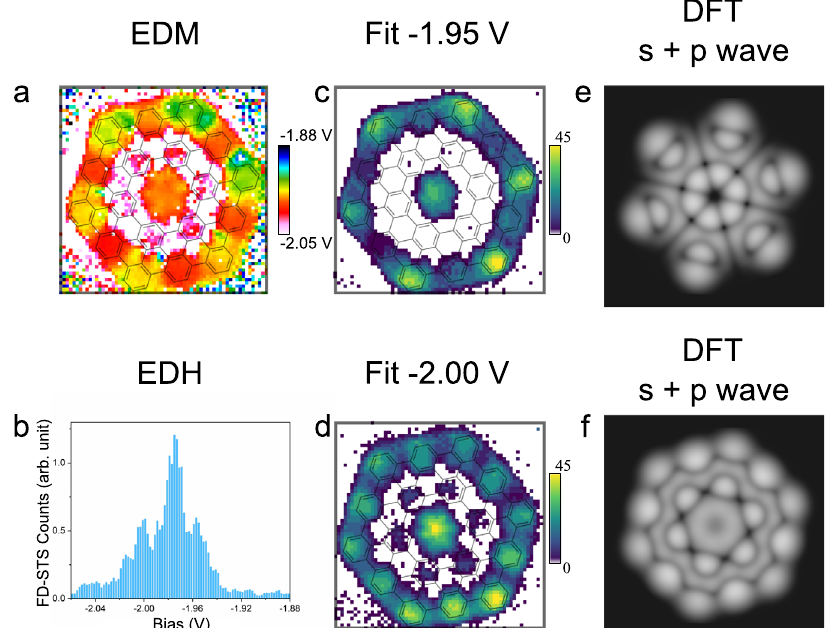
Fig. 7 Feature distribution and peak fi tting maps for PIR 3 and calculated molecular orbitals. a Feature distribution map of PIR 3, showing two clearly differentiated regions which is also re fl ected in the energy distribution histogram in ( b ). c , d Peak intensity maps, obtained by fi tting PIR 3 with two Lorentzians whose centers have been fi xed at − 1.95 V and − 2 V. e , f Visualization of the molecular wavefunctions as calculated by DFT using an sp-wave mixed tip at the resonance energies V PIR3 , = − 1.95 and − 2 V. EDM and peak intensity maps overlaid with the chemical structure of the C108. Image sizes are 2.4 × 2.4 nm 2